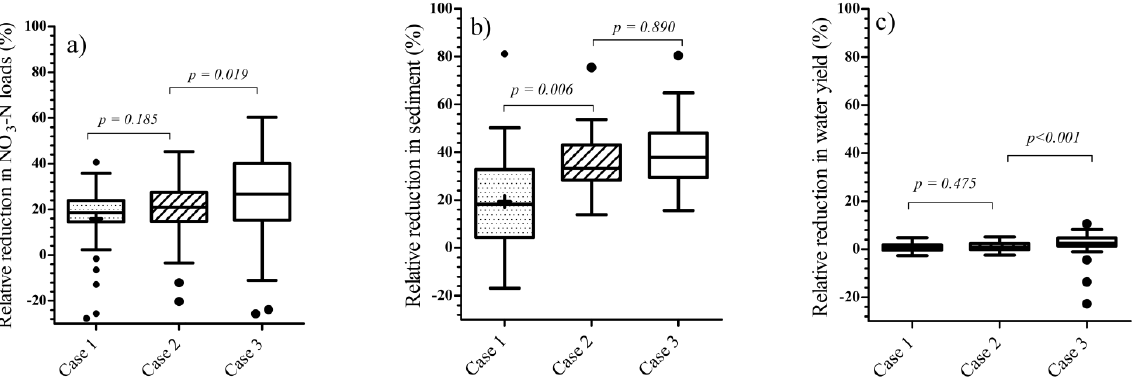
Figure 5. Relative reductions in: ( a ) NO 3 -N export; ( b ) sediment yield; and ( c ) water yield under different areal extents of land use change derived from applying three corn productivity thresholds of 3.1 Mg·ha −1 (Case 1), 4.7 Mg·ha −1 (Case 2), and 6.3 Mg·ha −1 (Case 3). The corresponding areal coverages are 3.2% of the watershed, 7.4%, and 14.3%, respectively. The relative reductions are comparisons between current land use (baseline condition) and conversion of areas below the above yield thresholds to